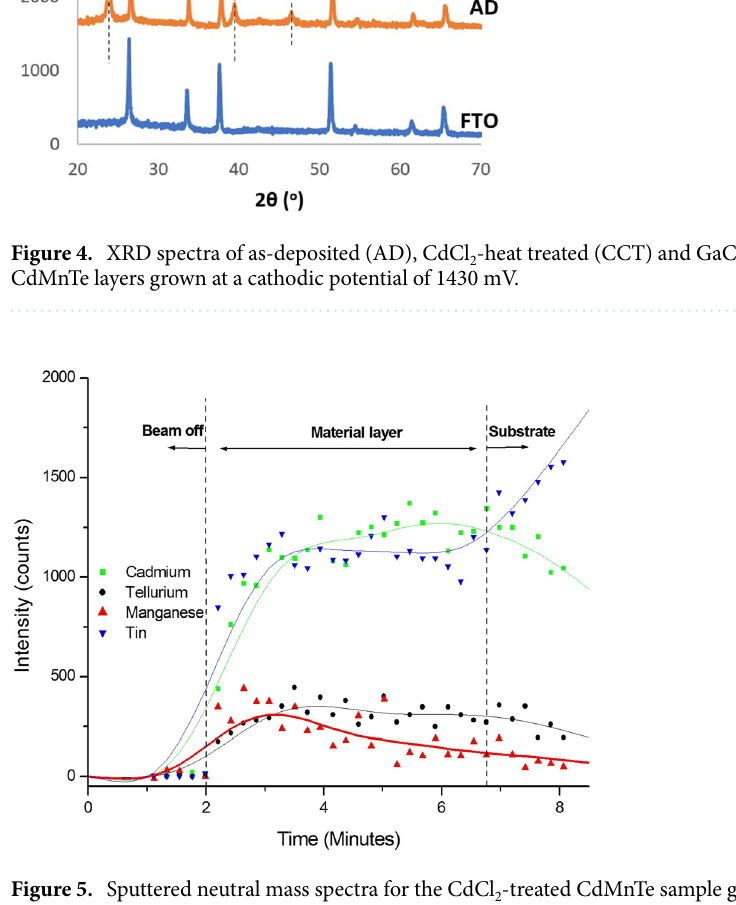
Figure 5. Sputtered neutral mass spectra for the CdCl 2 -treated CdMnTe sample grown at 1430 mV with corresponding 5-points Fast Fourier Transform (FFT)